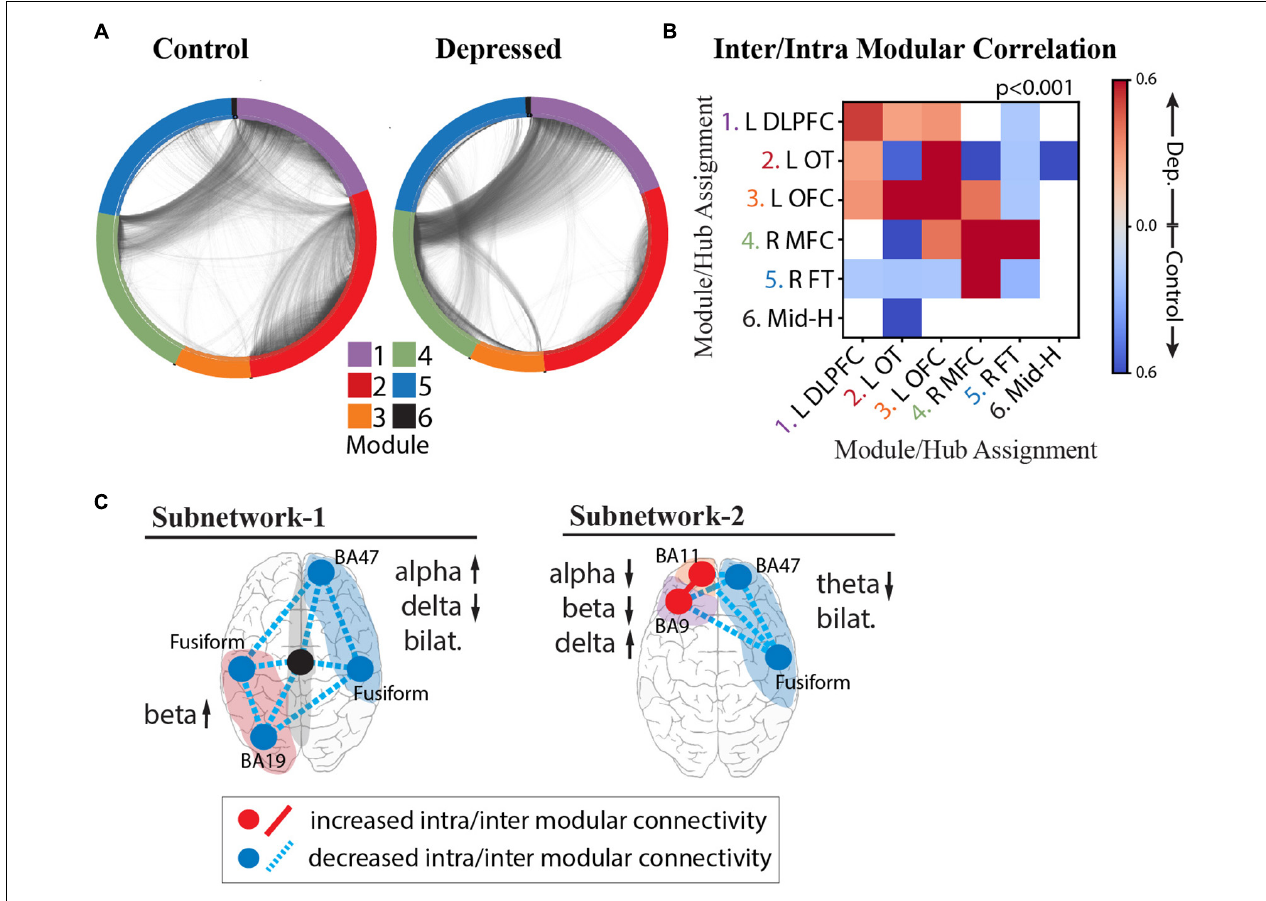
FIGURE 6 | Intra- and Inter-modular connectivity signatures of depression and control groups. (A) Connectivity structure derived using whole-brain iEEG model recalculated for the control group (left) and depressed group (right) with module membership delineated by the color of the nodes (electrodes), and edges (connections between electrodes) delineated by the black interconnecting lines. (B) Heatmap of significant Cohen’s d values calculated from the distribution of correlation strengths between depressed and control groups for each possible module pair and compared to Cohen’s d values for a null distribution derived from permuted nodal module assignment. Those that survived multiple comparison testing ( p < 0.001) were retained (red: increased connectivity for depressed group; blue: increased connectivity for control group; white: not significant). (C) Schematic of NEP-1 (left) and NEP-2 (right) showing both connectivity and spectral power underlying each pattern. Increased connectivity strength shown in red, and decreased connectivity shown in blue (hub = intramodular, line = intermodular connectivity). Color of shaded area refers to module number as shown in color legend in (A)